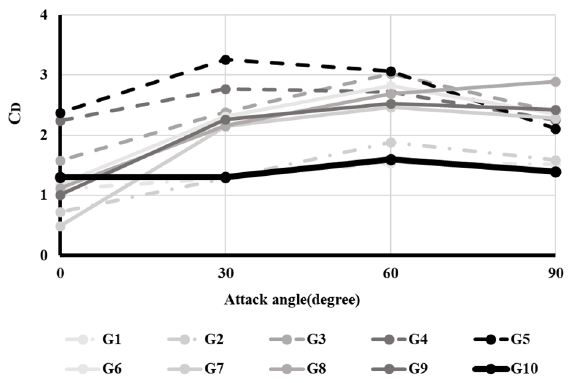
Figure 5. The relationships between the resistance coefficients (C D ) of floats (F1–F10) and their attack angles under 0.75 m/s flow conditions.